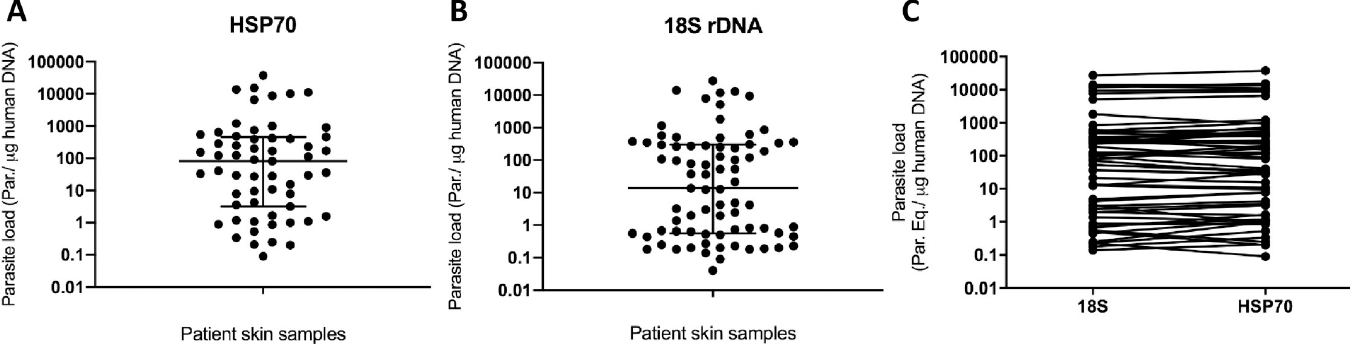
Fig 3. Normalized parasite load distribution on positive patient samples. (A) Parasite load distribution on the 59 positive patient samples for the HSP70 target. (B) Parasite load distribution on the 77 positive patient samples for the 18S rDNA target. (C) Direct comparison between Leishmania parasite load quantification by qPCR reactions with 18S rDNA versus the HSP70 target. In this graph, parasite load of the 59 positive patient samples for both targets are